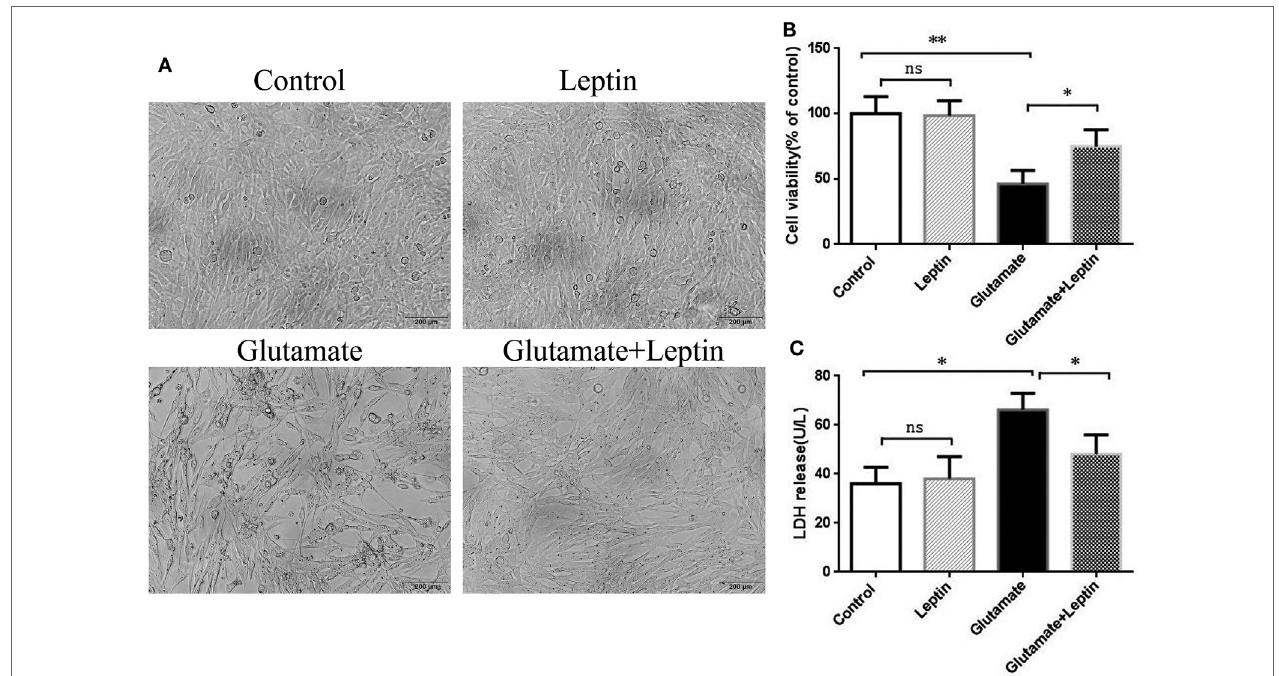
FigUre 1 | Neuroprotective effects of leptin against glutamate-induced excitotoxicity. ( a) The morphology of HT22 cells were visualized under a light microscope; (B) cell viability was measured by CCK8 assay; (c) neurotoxicity was measured by lactate dehydrogenase assay. * P < 0.05, ** P < 0.01; ns, not